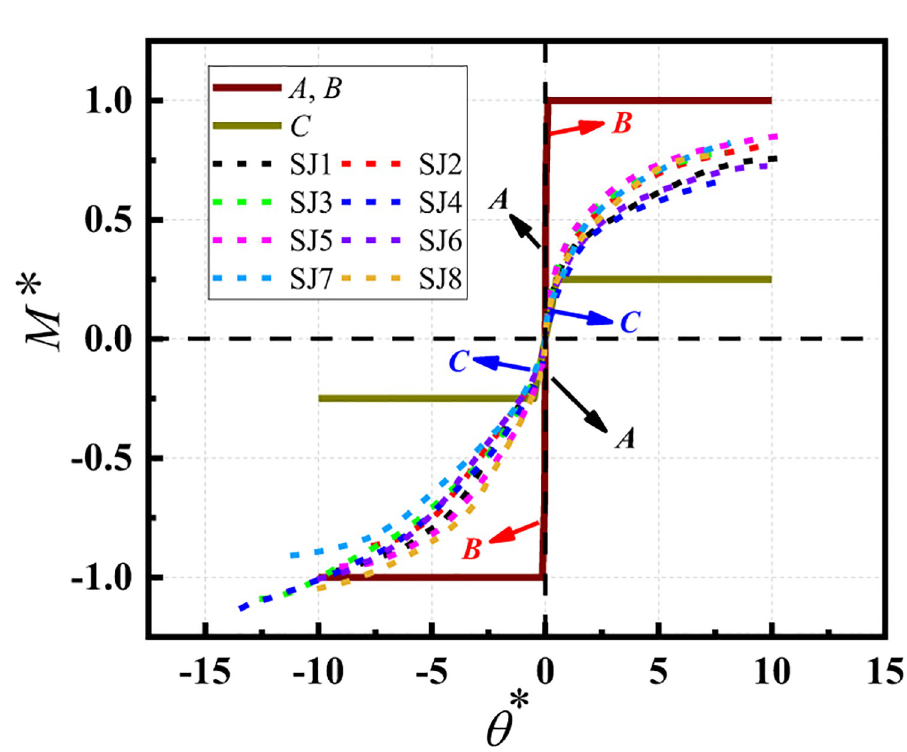
Fig 11. Rigid regions of the experimental